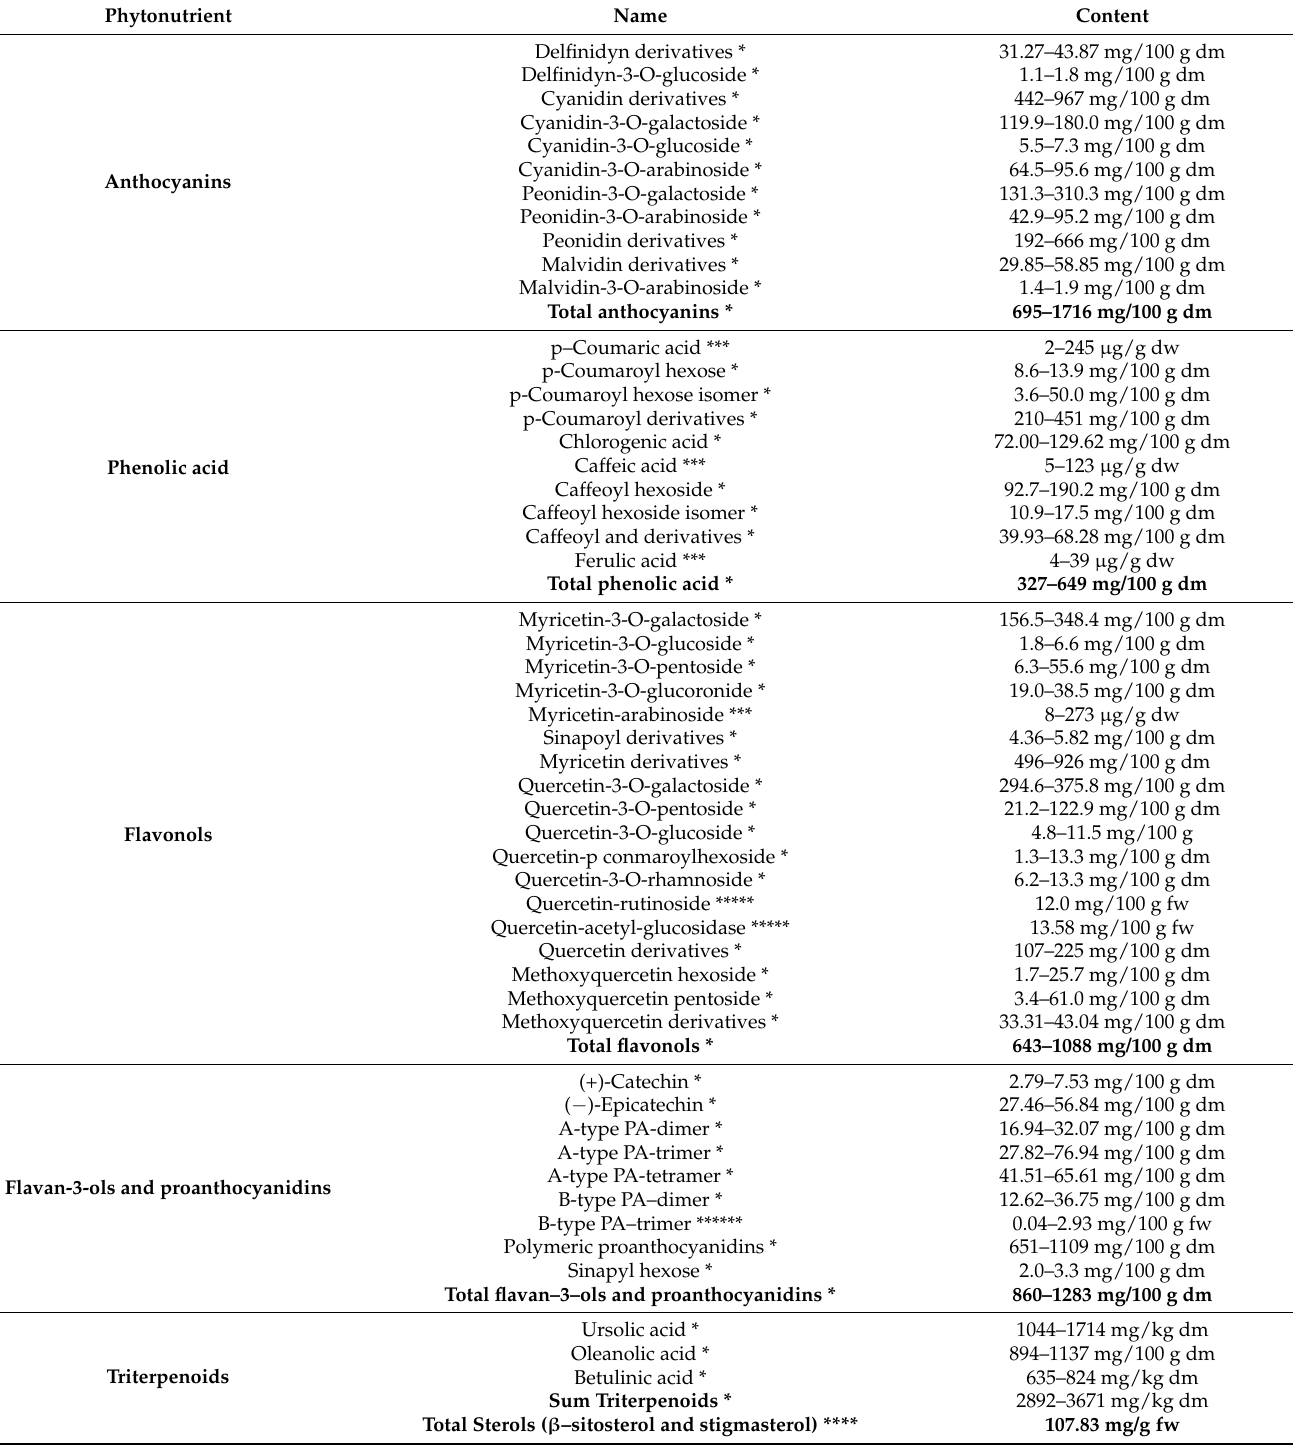
Table 4. Phytonutrients in cranberry (adapted from